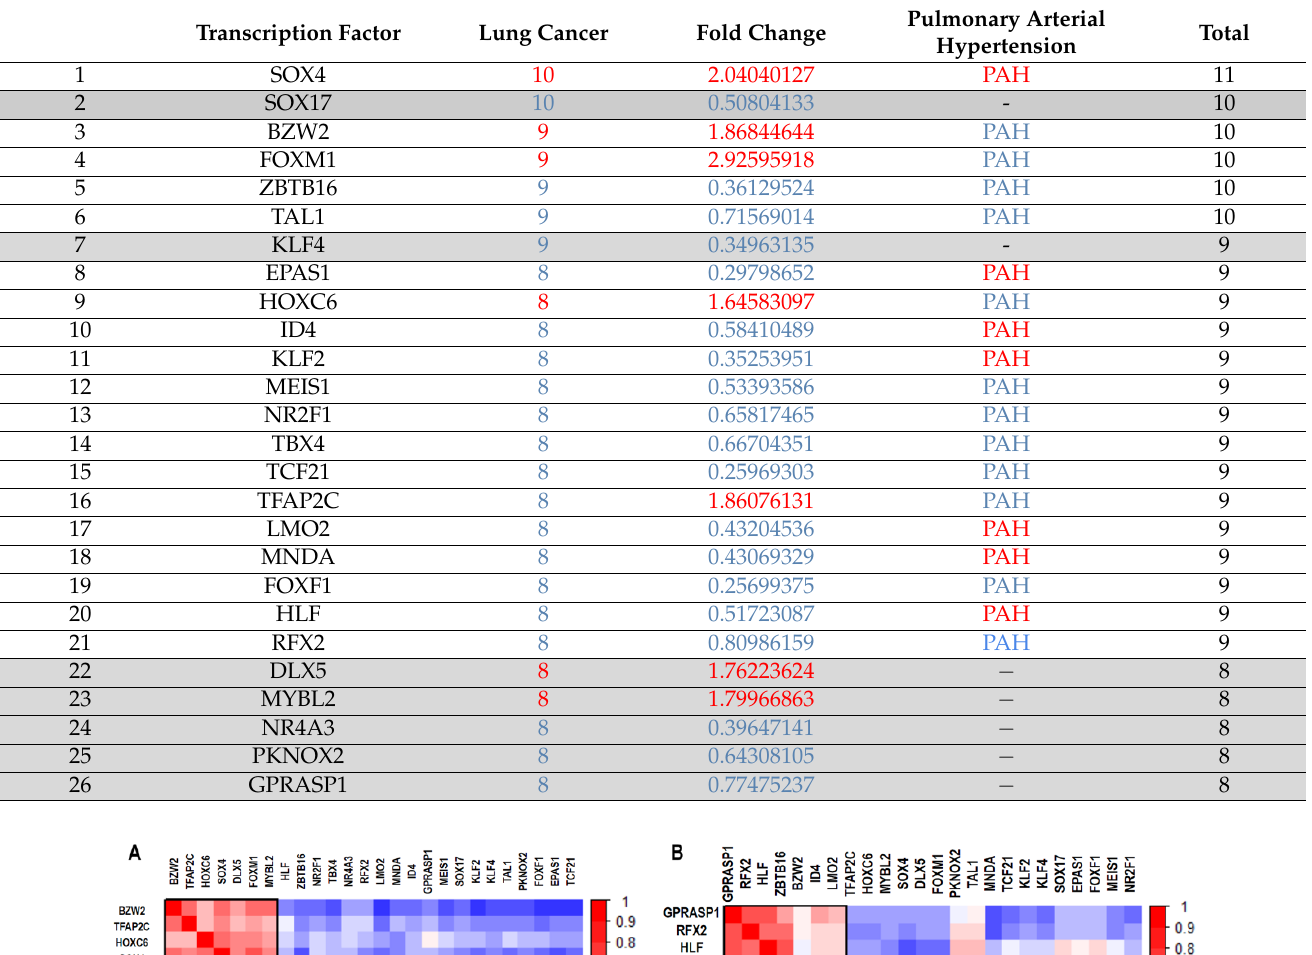
Table 2. The most frequently dysregulated lung cancer transcription factors and their fold change. In blue are the downregulated transcription factors, and in red the upregulated transcription factors in lung cancer and pulmonary arterial hypertension (PAH). The gray shading highlights the transcription factors that are dysregulated only in lung cancer.